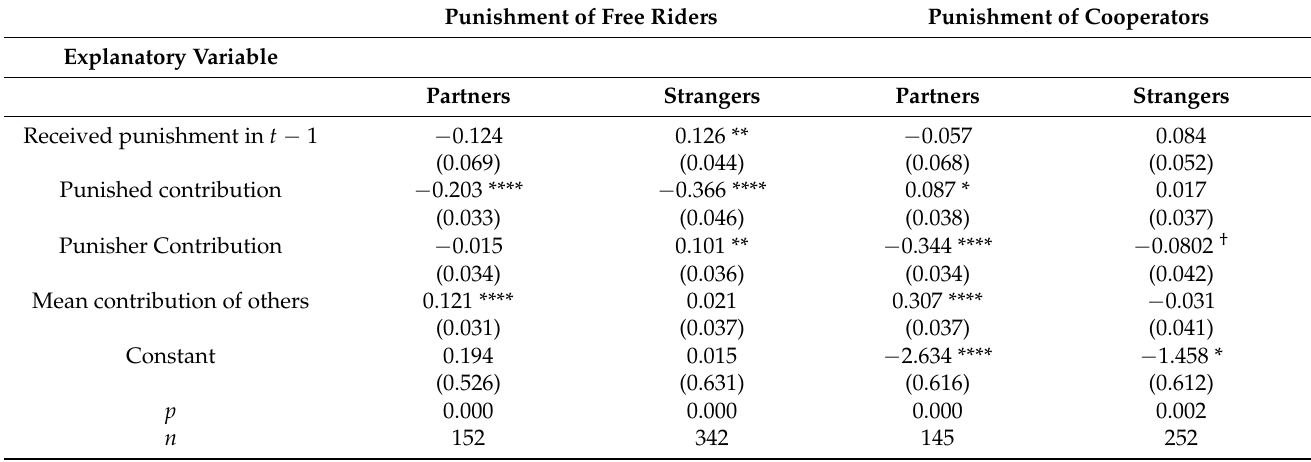
Table 1. Results of Tobit regression analyses coefficients (& Std. Err) on the points assigned to punishment as the dependent variable.